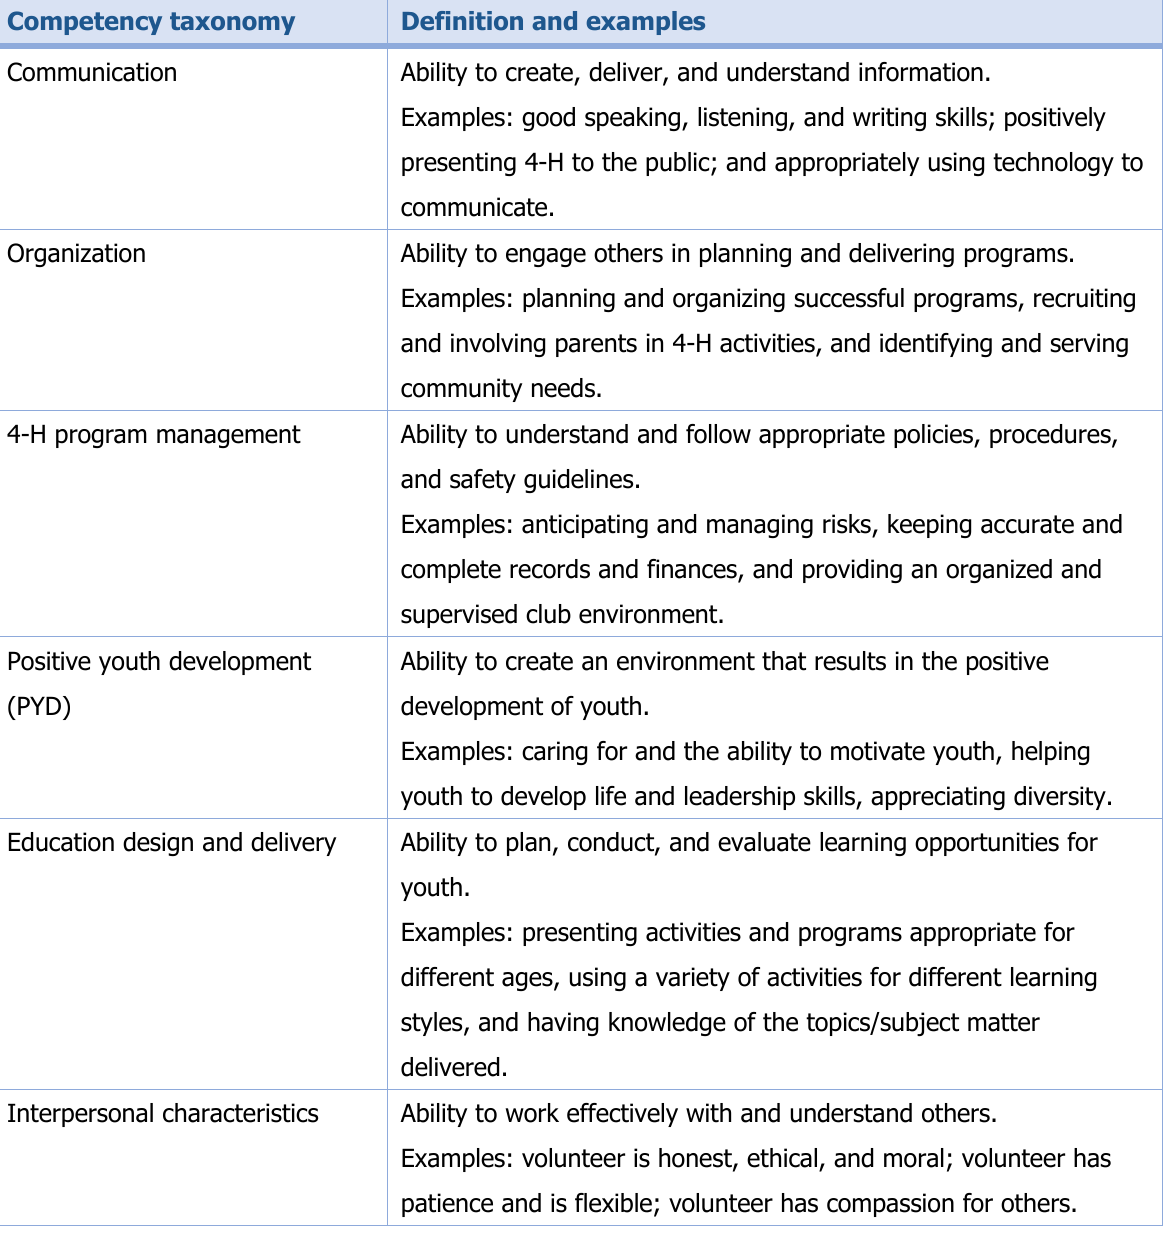
Table 1. Volunteer Research Knowledge Competency (VRKC) Taxonomy Adopted by the National 4-H Council